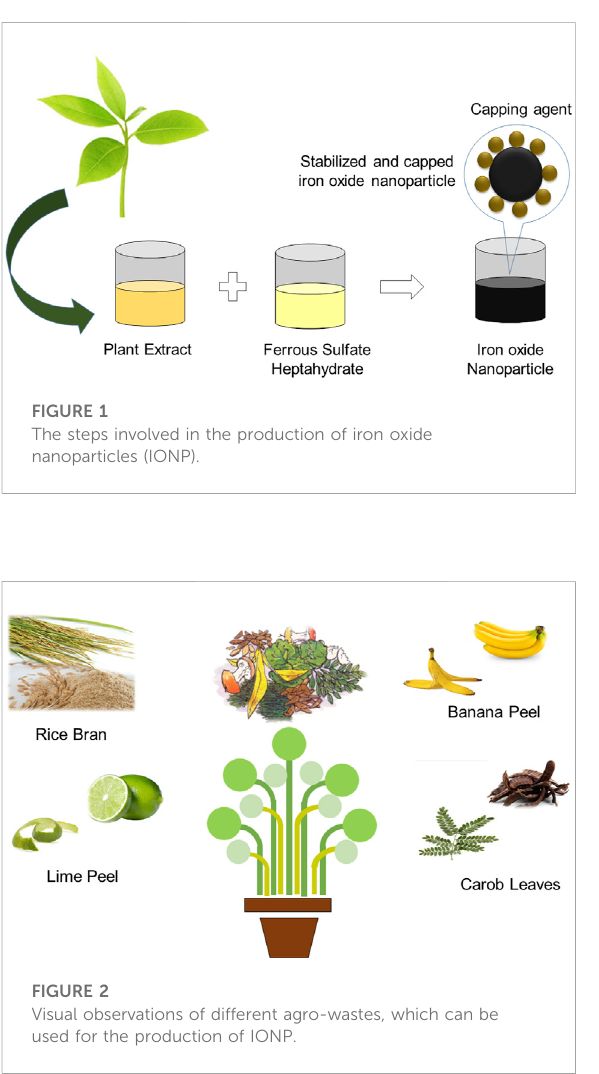
FIGURE 2 Visual observations of different agro-wastes, which can be used for the production of